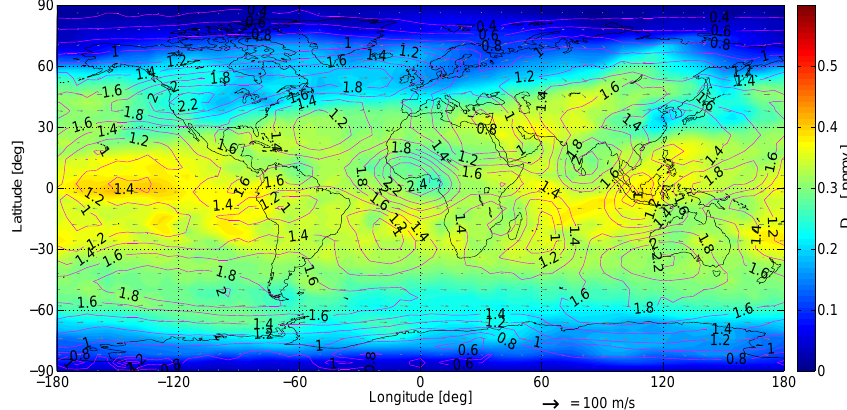
at 5hPa in March as a function of longitude and latitude. A daytime average of horizontal wind Figure 7a. Monthly mean modelled D O 3 (grey arrows) from 09:00 to 15:00LT is overlaid and a reference for wind speed is given near the x axis. The magenta contour lines refer to the peak-to-valley difference D T in temperature given in K.